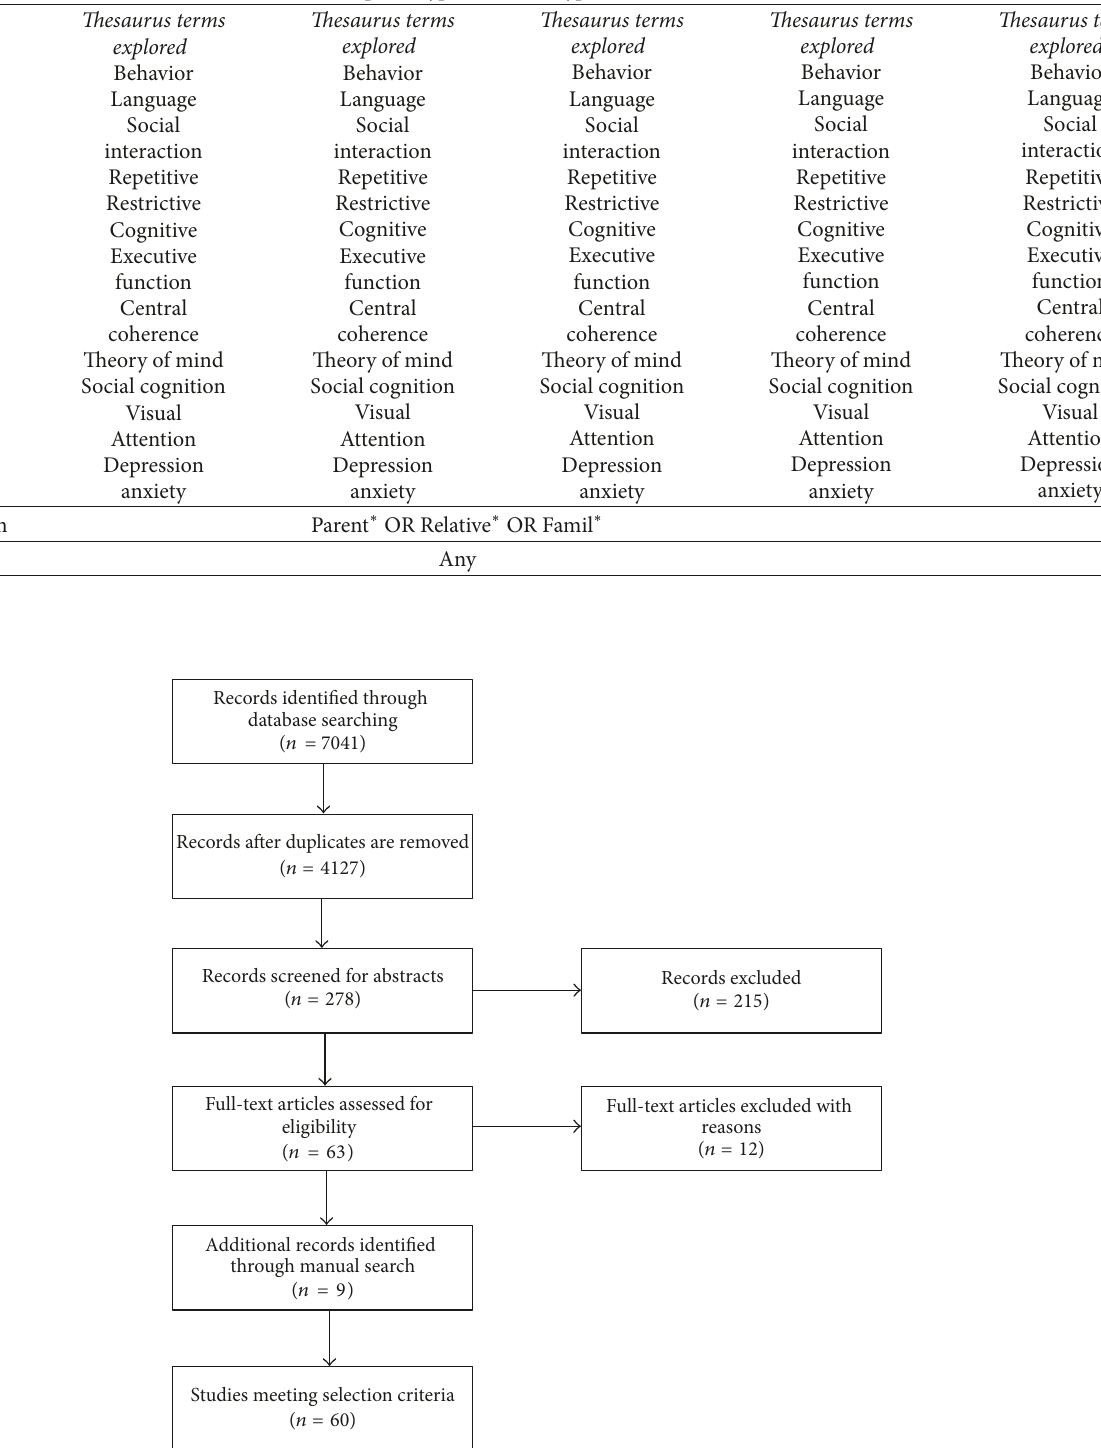
Figure 1: Flow chart of study